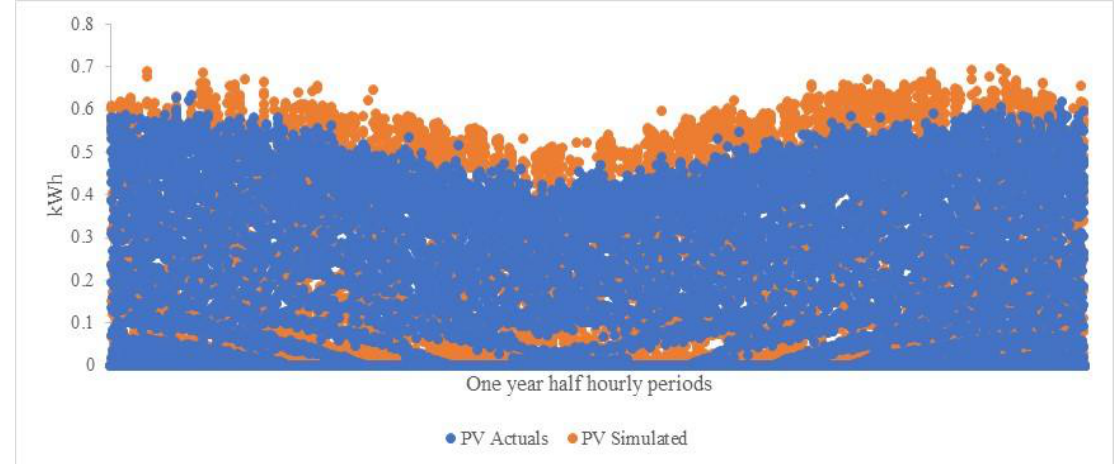
Figure 9. Simulated and historical PV production, 1 yr half-hourly.